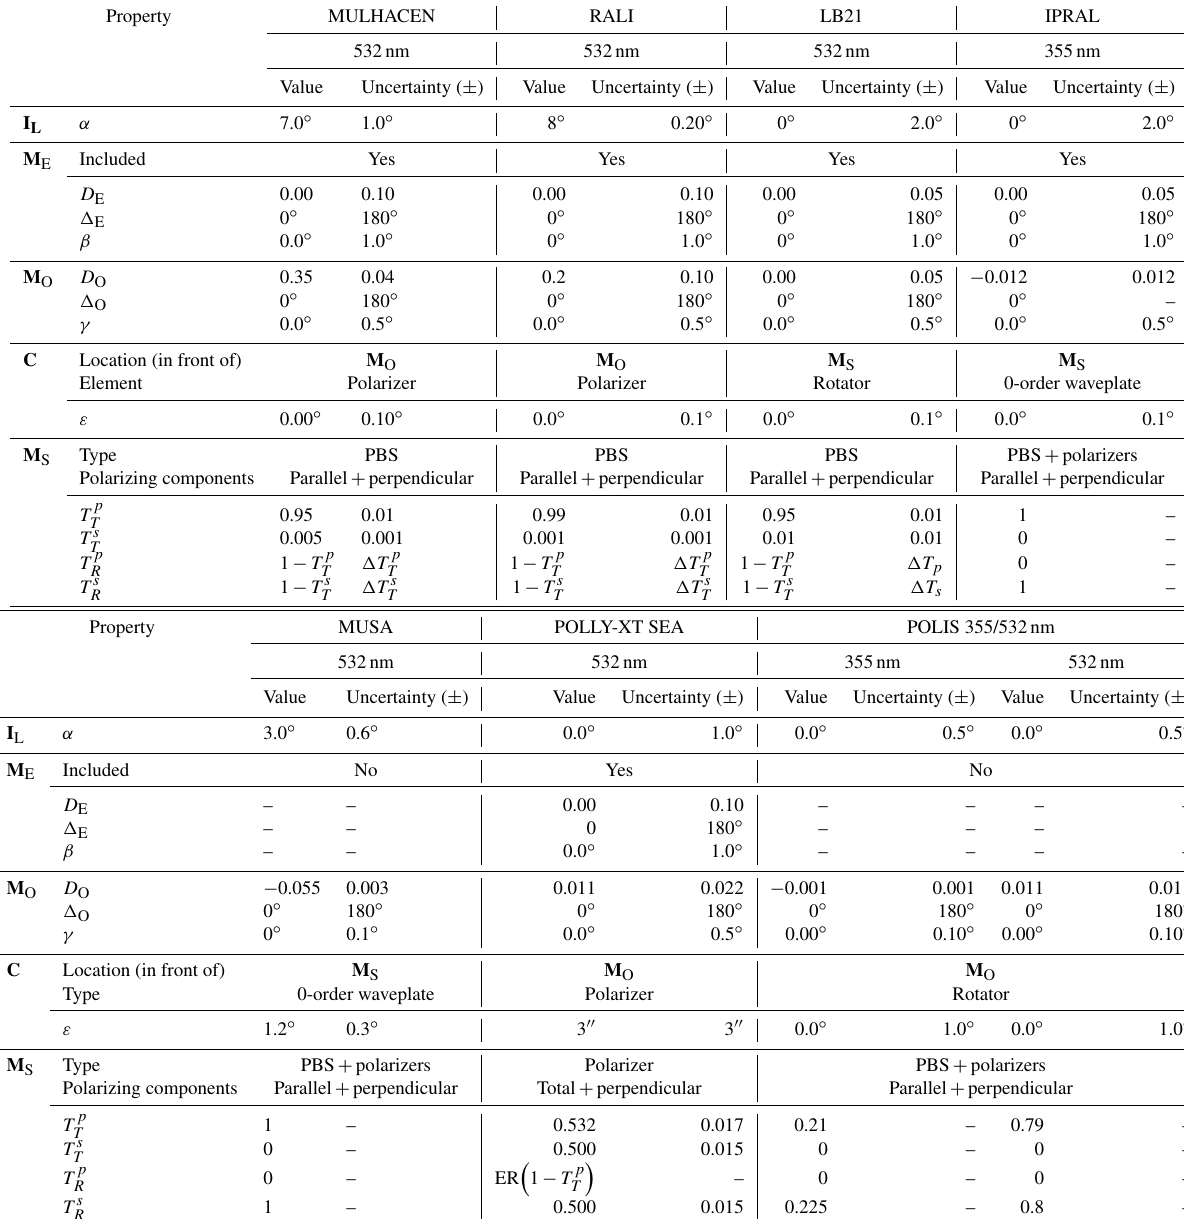
Table 5. Values and uncertainties of each lidar parameter for the set of simulated EARLINET lidars. (cid:49)T p uncertainties. ER is the linear-polarizer extinction